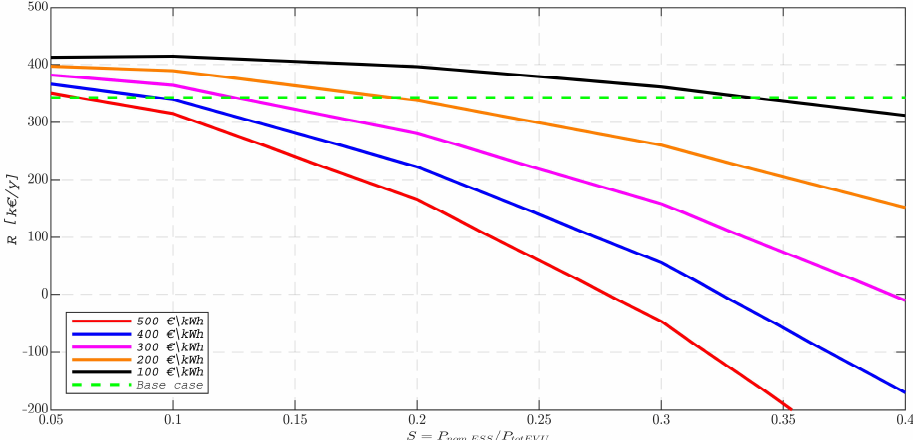
Figure 11. Storage size and cost sensitivity analysis.